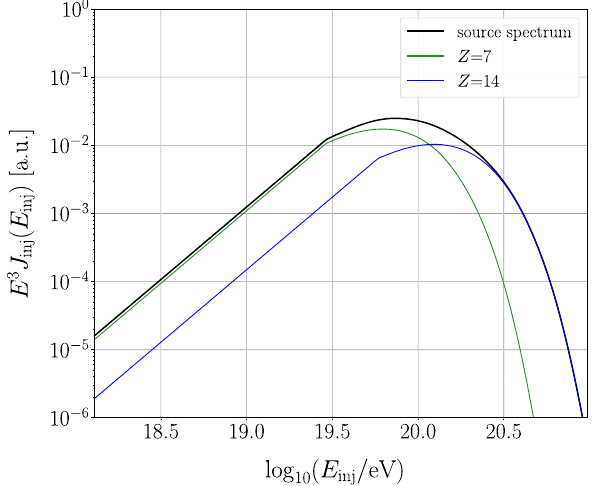
Fig. 1 Injected spectrum using the best-fit source parameters from [3], following a power law with a broken exponential cutoff above a maxi- mum rigidity as given by Eq. (1)